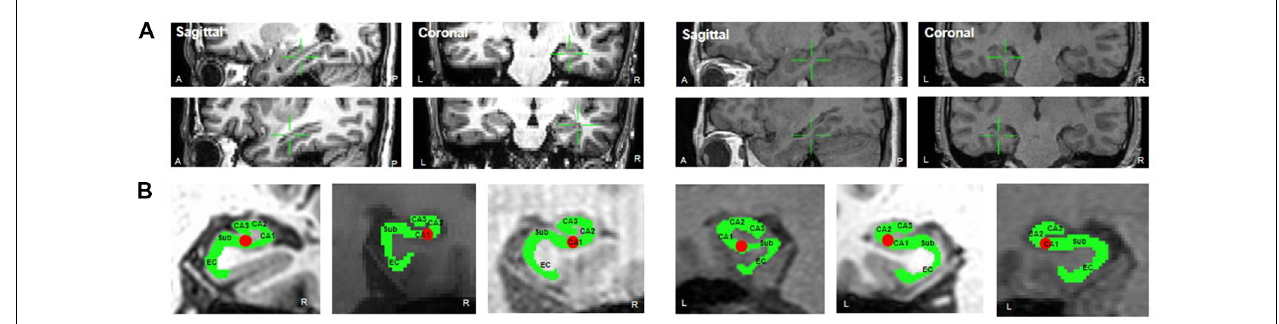
FIGURE 1 | (A) Location of stimulation. The green crosshair denotes the location of the stimulation electrode in the right mid-hippocampus (sagittal and coronal, respectively) in Patient 1 (left two panels, anode and cathode, respectively) and in the left mid-hippocampus in Patient 2 (right two panels). (B) The hippocampal subregions in each patient and one hippocampal electrode in the region of